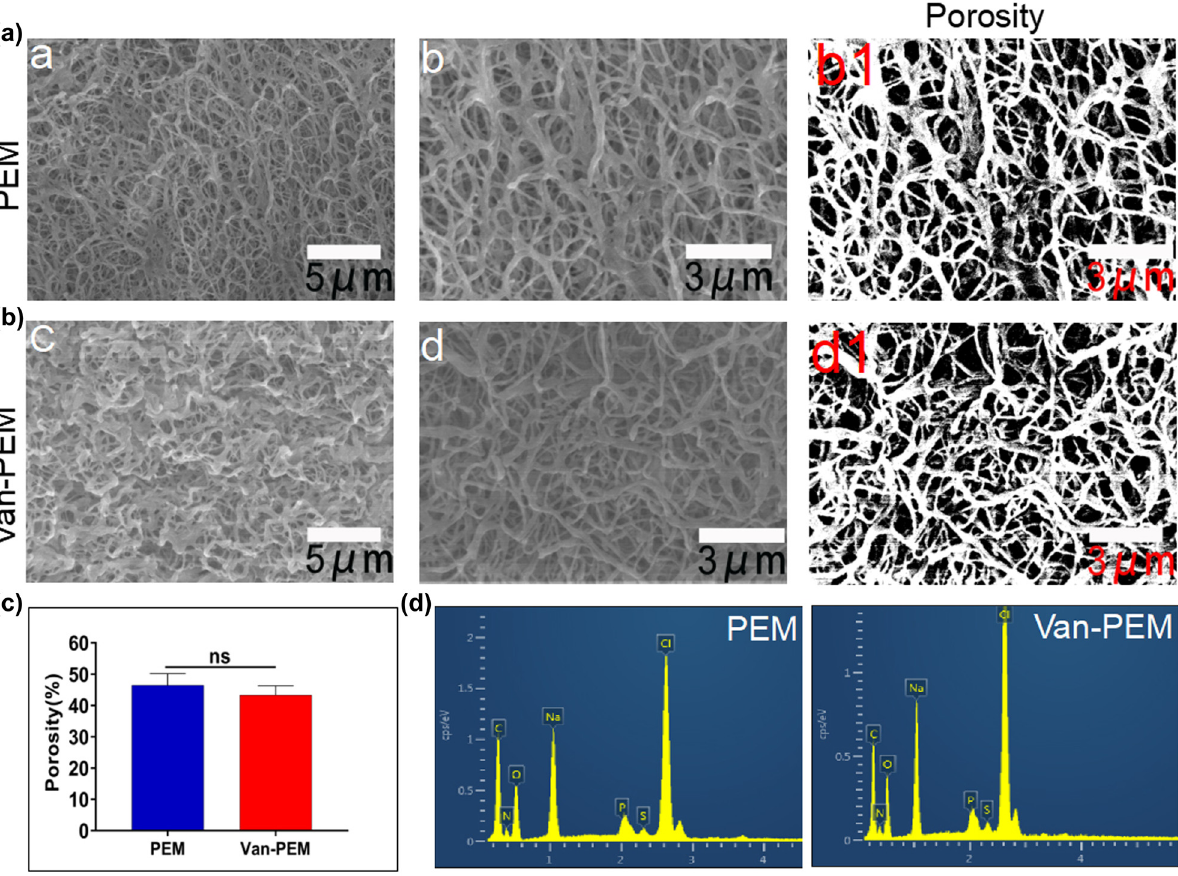
Figure 2: [( a ) Microstructure of the PEM hydrogel at 5,000 × ( a ) and 10,000 × ( b ) ; ( b1 ) is the condition of ( b ) after ImageJ software processing ] . [( b ) Microstructure of the Van - PEM hydrogel at 5,000 × ( c ) and 10,000 × ( d ) ; ( d1 ) is the condition of ( d ) after ImageJ software processing ] . ( c